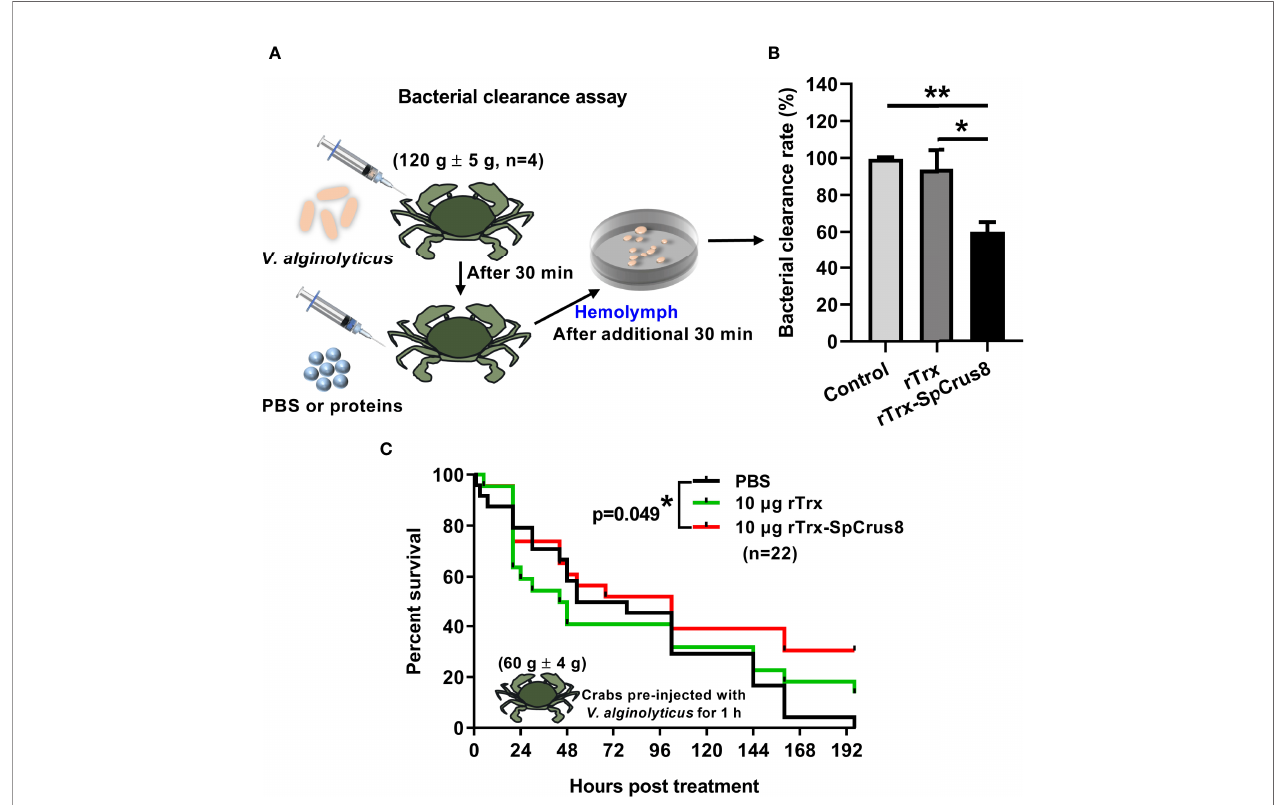
FIGURE 5 | Effects of rTrx-SpCrus8 treatment on hemolymph bacterial clearance and immune protection in crabs infected with V. alginolyticus . (A) Schematic diagram of the bacterial clearance experiment in S. paramamosain . (B) The bacterial clearance rate of V. alginolyticus in hemolymph after rTrx-SpCrus8 or rTrx treatment in vivo (n=4). (C) The survival curve of mud crabs infected with V. alginolyticus after rTrx-SpCrus8 or rTrx treatment. Male crabs were challenged with V. alginolyticus , and injected with rTrx-SpCrus8 or rTrx (10 m g crab -1 ) 1 h after bacterial challenge (n=22). Signi fi cant difference was indicated with asterisks, *p<0.05 and **p <